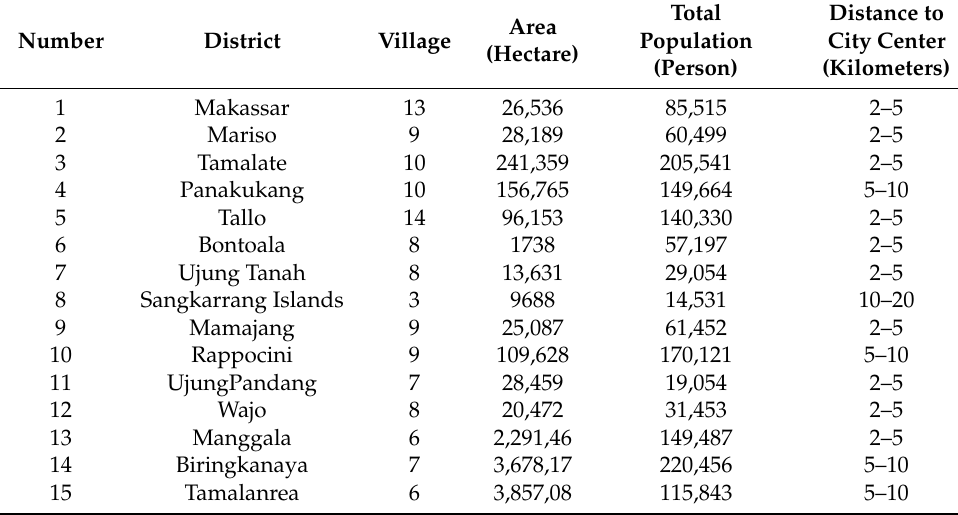
Table 1. Total population of Makassar City and the location distance to the city center.